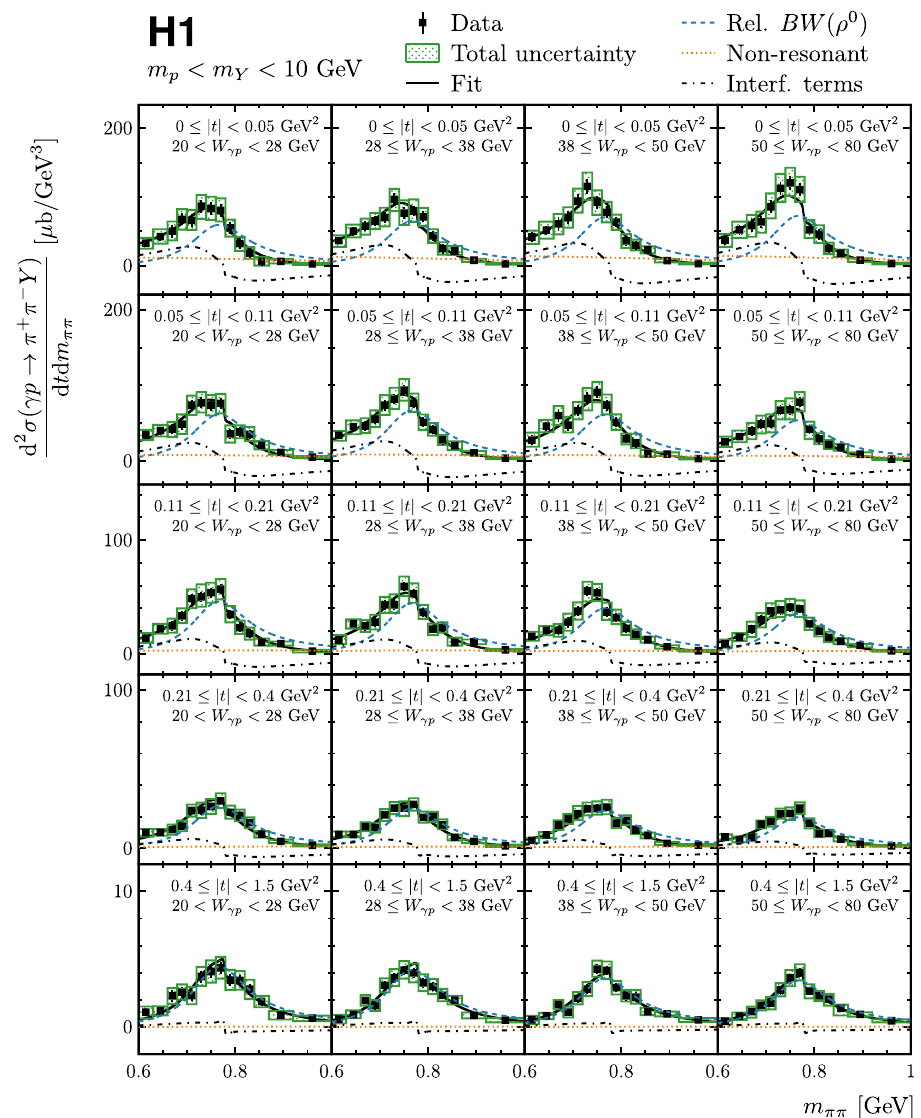
Fig. 16 Proton-dissociative ( m p < m Y < 10 GeV) double-differential π + π